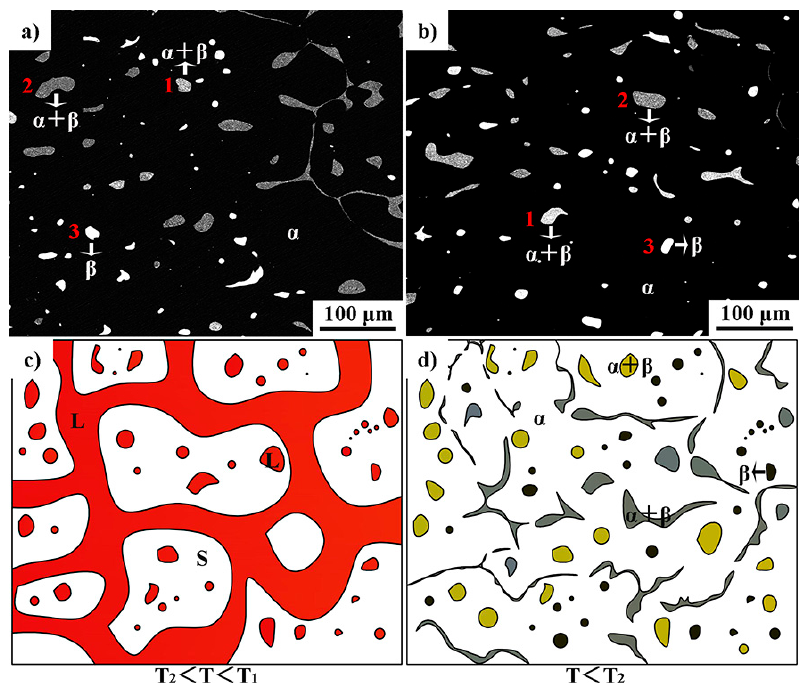
Figure 4. Microstructures of the mushy zone under different high pressures. ( a ) 1 GPa; ( b ) 3 GPa; ( c , d ) schematic diagram of the melting and solidification process of the mushy zone. Table 1. Compositions of bright phases obtained under di ff erent pressures in the mushy zones. Pressure / GPa Phase Al / at% Ni /